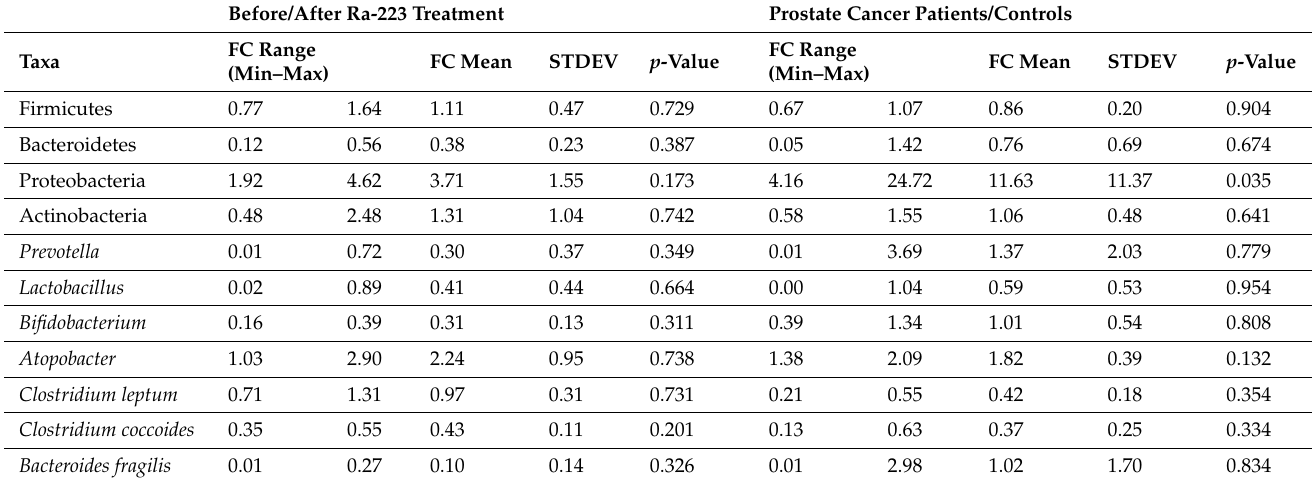
Table 3. The fold-change (FC) of the intervention samples, compared with the unintervention samples, normalized for the reference